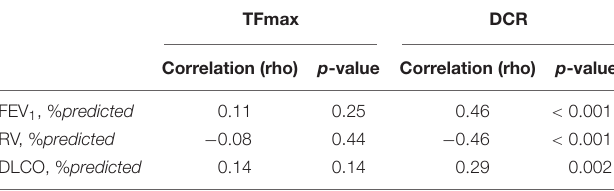
TABLE 3 | Correlations between ultrasound variables and lung function testing. TFmax DCR